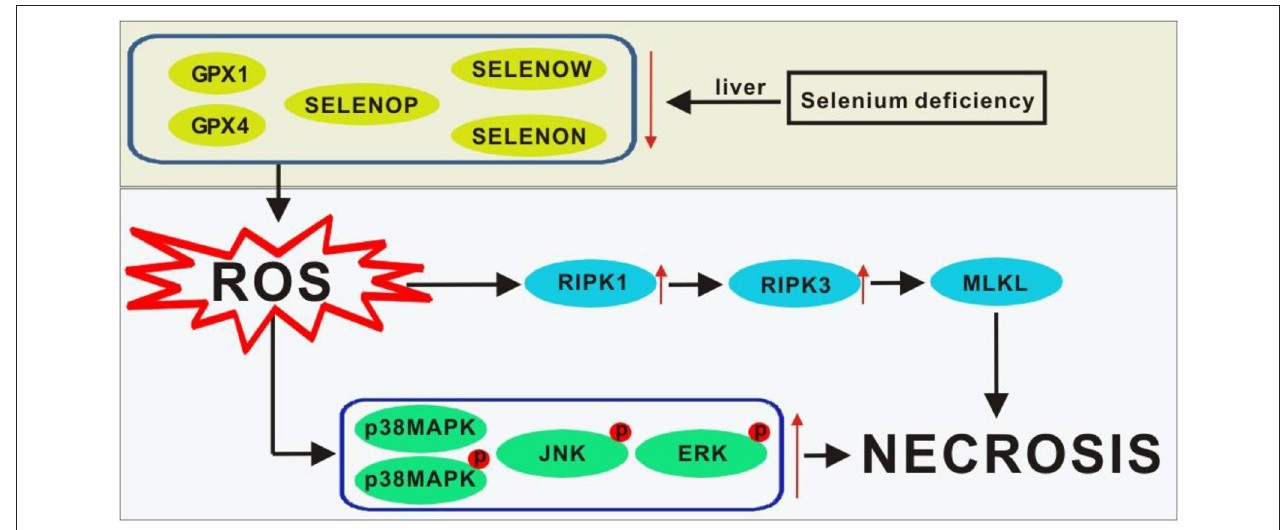
FIGURE 5 | Scheme of postulated regulatory pathways and mechanisms for the liver necrosis induced by Se deficiency. Lines ending with arrows, activation or increase; ↑ , activation or increase; ↓ , inhibition or decrease. GPX1, glutathione peroxidase-1; GPX4, glutathione peroxidase-4; MLKL, mixed lineage kinase domain-like; p38MAPK, p38 mitogen-activated protein kinase; p -p38MAPK, phosphorylated p38MAPK; p-JNK, phosphorylated JNK; p-ERK, phosphorylated ERK; ROS, reactive oxygen species; RIPK1, receptor-interacting serine-threonine kinase 1; RIPK3, receptor-interacting serine -threonine kinase 3; Se, selenium;